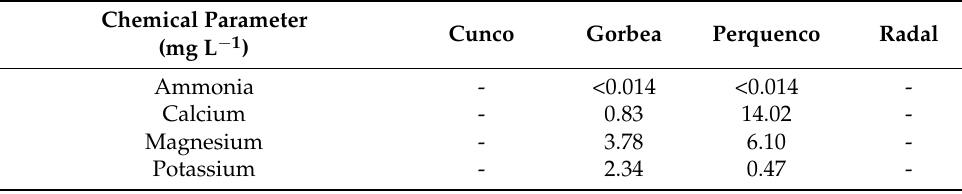
Table 4. Borehole water samples collected between May and June of 2018.